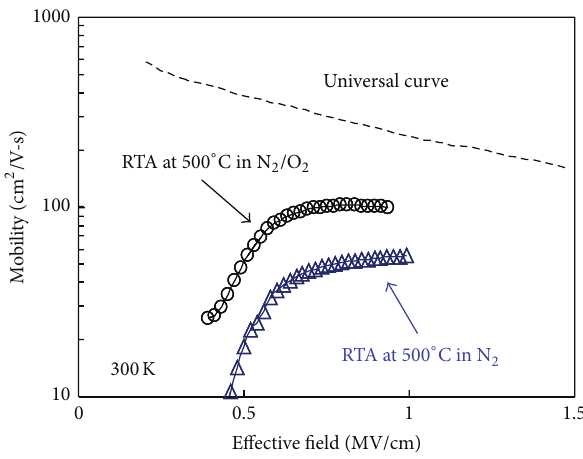
Figure 4: Channel electron mobility versus effective surface field for the HfO 2 MOSFETs annealed at 500 ∘ C for 60s in N 2 and N 2 /O 2